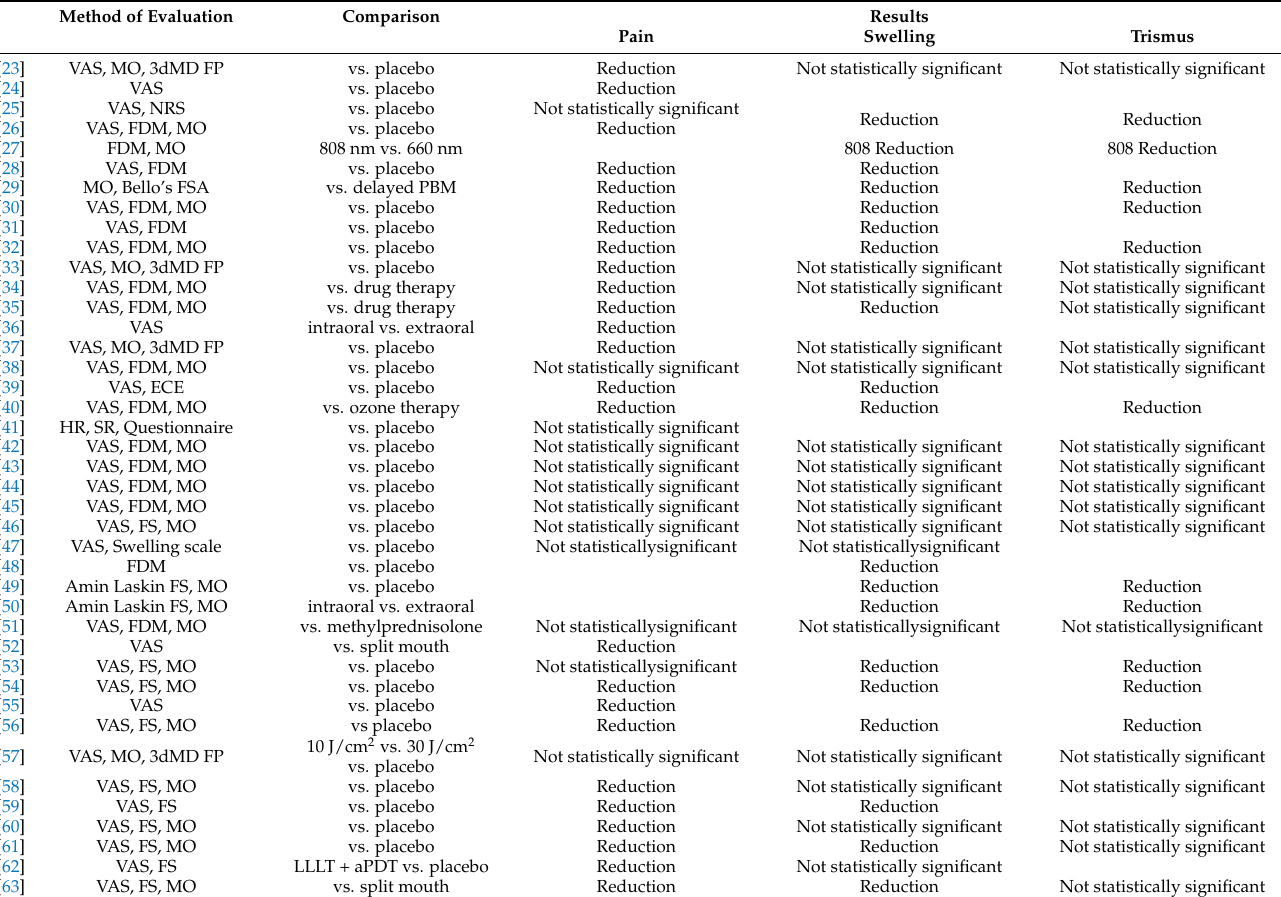
Table 2. Method of evaluation of the outcomes and main results of the included